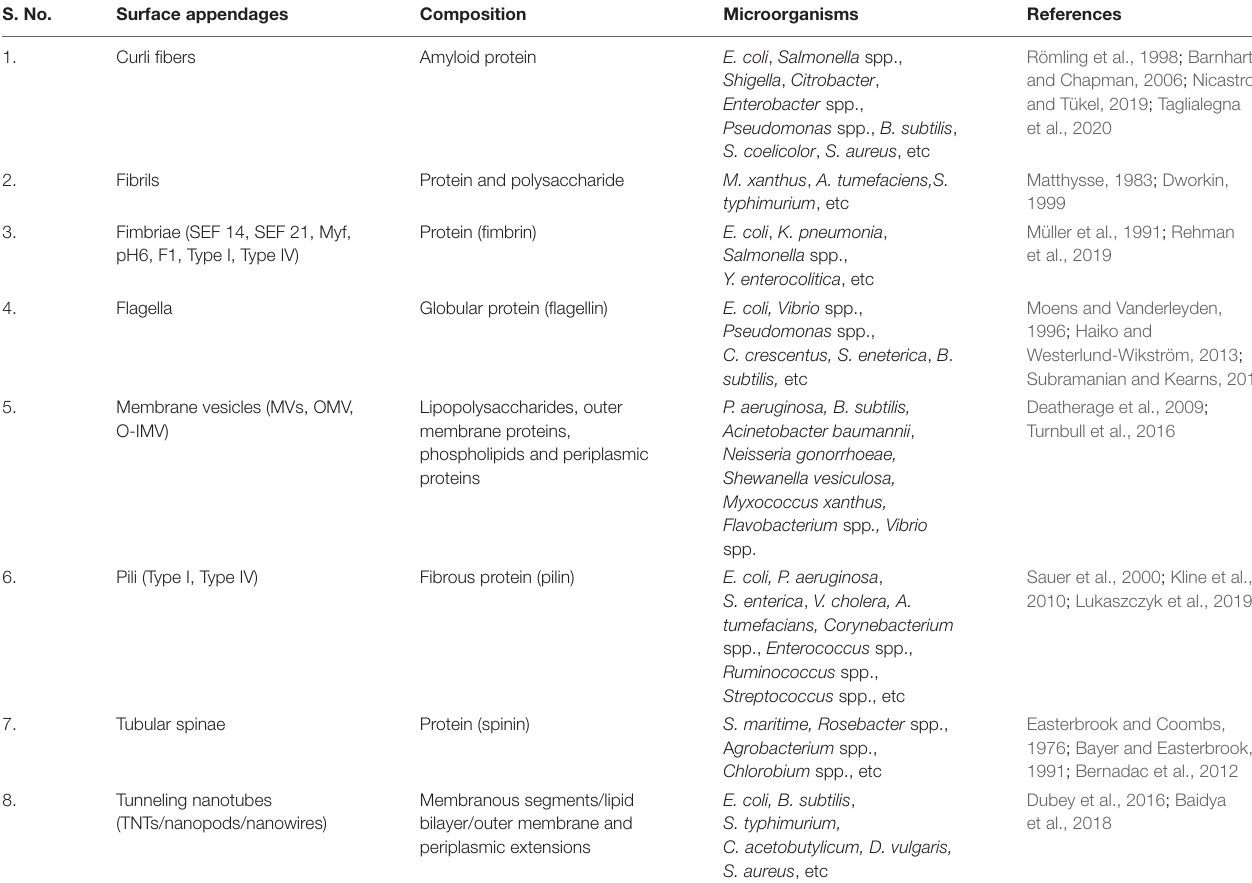
TABLE 1 | Bacterial surface appendages, composition and the list of microorganisms. S.